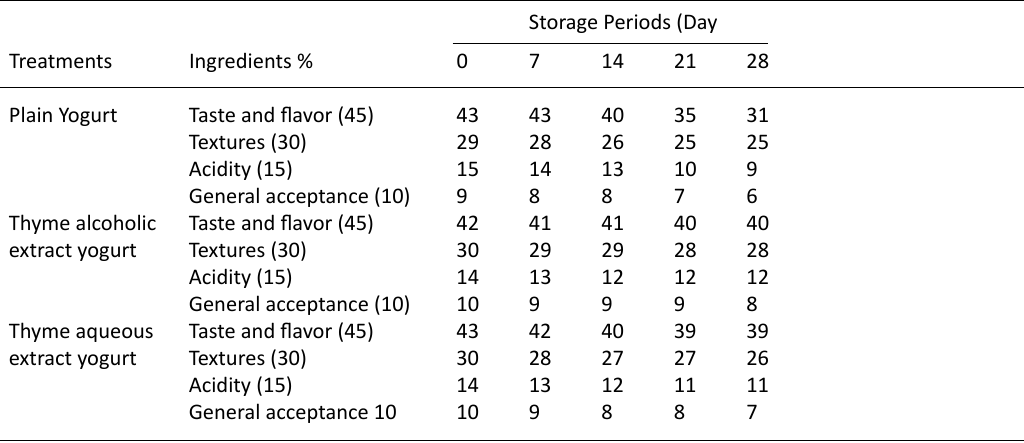
Table 4. Sensory evaluation of plain yogurt, thyme alcoholic extract yogurt and thyme aqueous extract yogurt